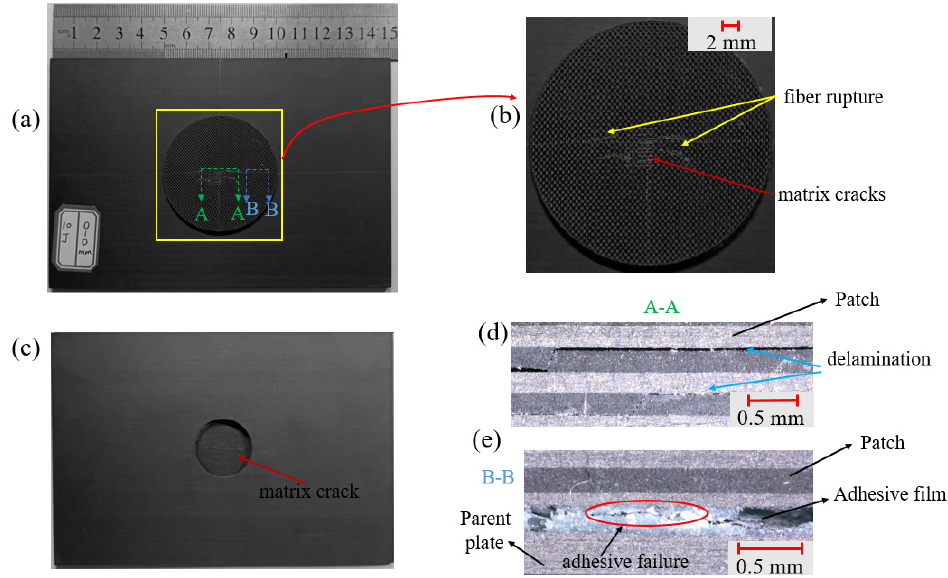
Figure 8. Micrographs of the patch-repaired specimen after the third impact at an impact distance of 0 mm: ( a ) the front part, ( b ) local figure of the patch, ( c ) the back part, ( d ) the side view part and ( e ) the A-A section.